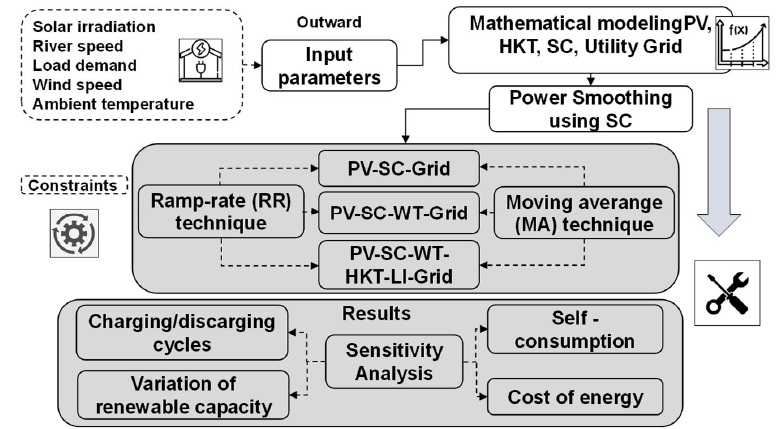
Figure 1. Flowchart of the proposed methodology. Figure 2. System topology and information flows of PV ‐ HKT ‐ WT ‐ LI ‐ Grid ‐ Load demand and SC.